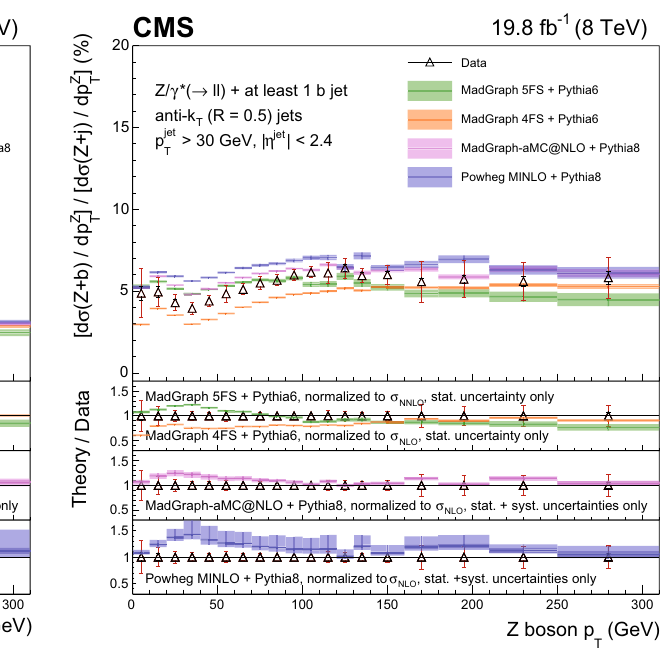
Fig. 6 Differential fiducial cross section for Z(1b) production as a functionoftheZboson p T ( left ),andthecrosssectionratioforZ(1b)and Z+jetsproductionasafunctionoftheZboson p T ( right ),comparedwith the MadGraph 5FS, MadGraph 4FS, MadGraph5 _a MC@NLO , and powheg minlo theoretical predictions ( shaded bands ), normal- ized to the theoretical cross sections described in the text. For each